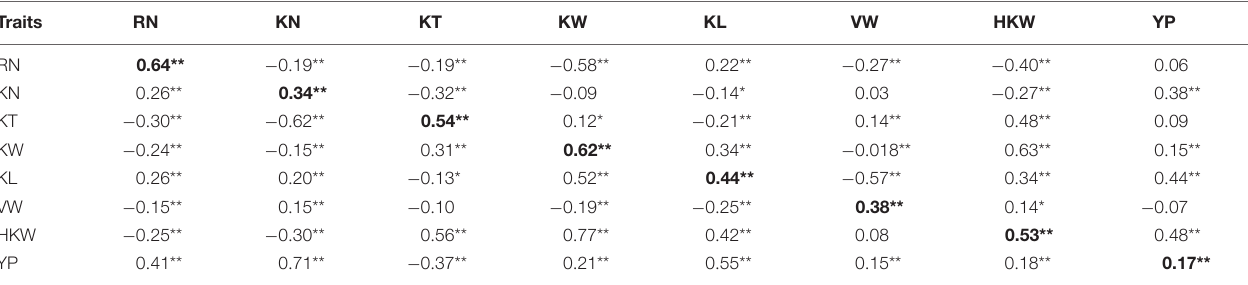
FIGURE 1 | Phenotypic variation in eight traits in different populations. (A) The means and ranges of eight yield-related traits in the RILs and their testcross progenies. (B,C) Phenotypic variation of per se performances and their GCA effects for eight yield-related traits. The histograms inside each hexagon indicate the distribution of phenotypic values for each trait. RN, Row number; KN, Kernel number per row; KT, Kernel thickness; KW, Kernel width; KL, Kernel length; HKW, 100-kernel weight; VW, Volume weight; YP, Yield per plot. TABLE 1 | Phenotypic correlation coefficients ( r ) between per se performances and GCA effects for eight yield-related